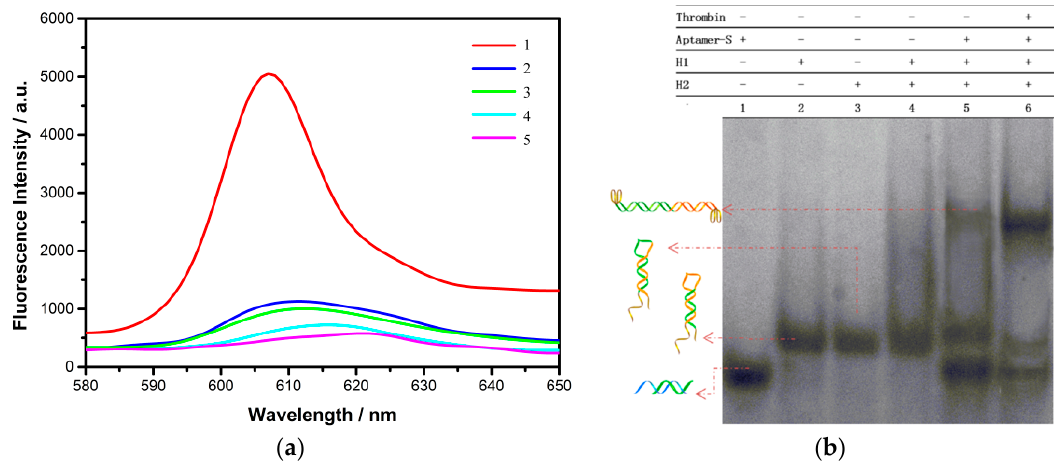
Figure 5. ( a ) Fluorescence spectra of NMM of different samples: (1) Aptamer-S, H1, H2, and